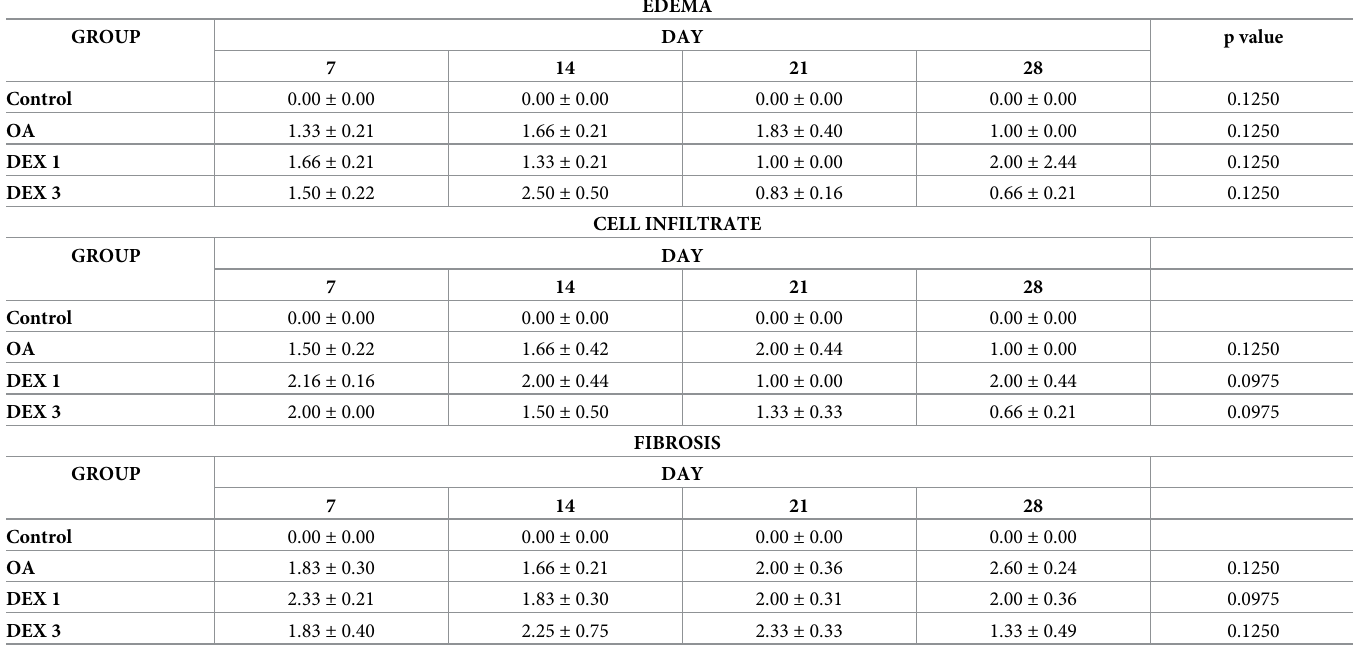
Table 2. Histopathological analysis of the synovial membrane of the control, OA, DEX-1 and DEX-3 groups relative to the parameter edema, cell infiltrate and fibrosis.